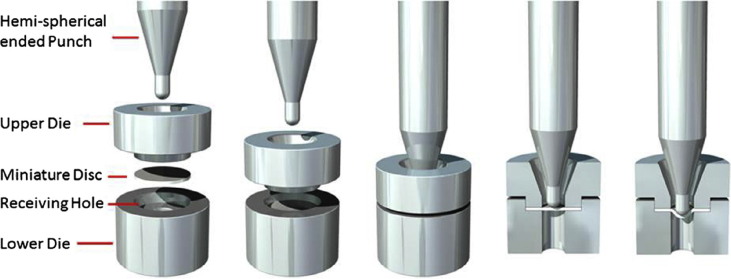
Schematic of the small punch test showing the location of the small punch specimen and upper/lower dies. From Hurst et al. [2016].38